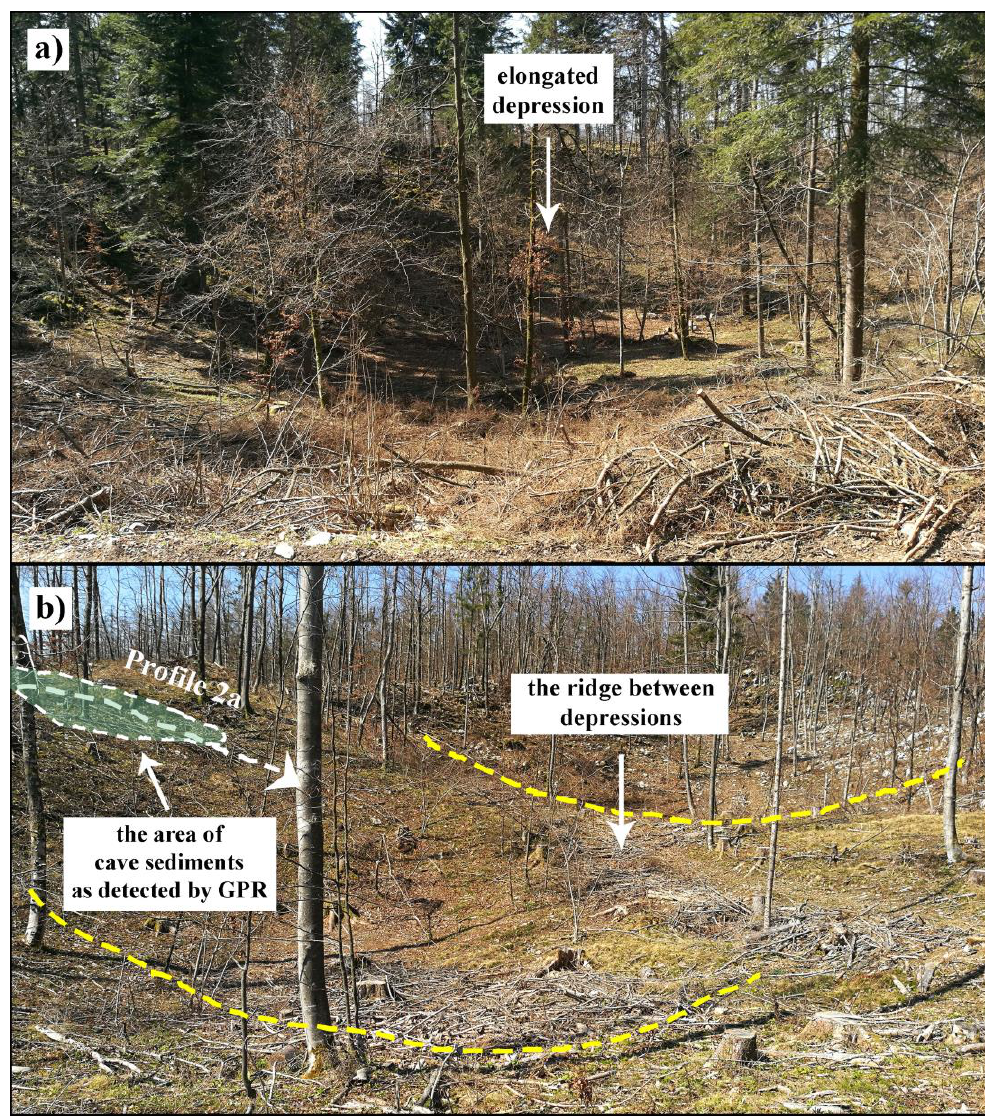
Figure 9. Surface topography in the vicinity of detected cave sediments: ( a ) An elongated depression at the location of Profile 1; ( b ) The surface morphology in the area of Profiles 2a and 2b, where depressions pass from one to another with intervening small ridges.